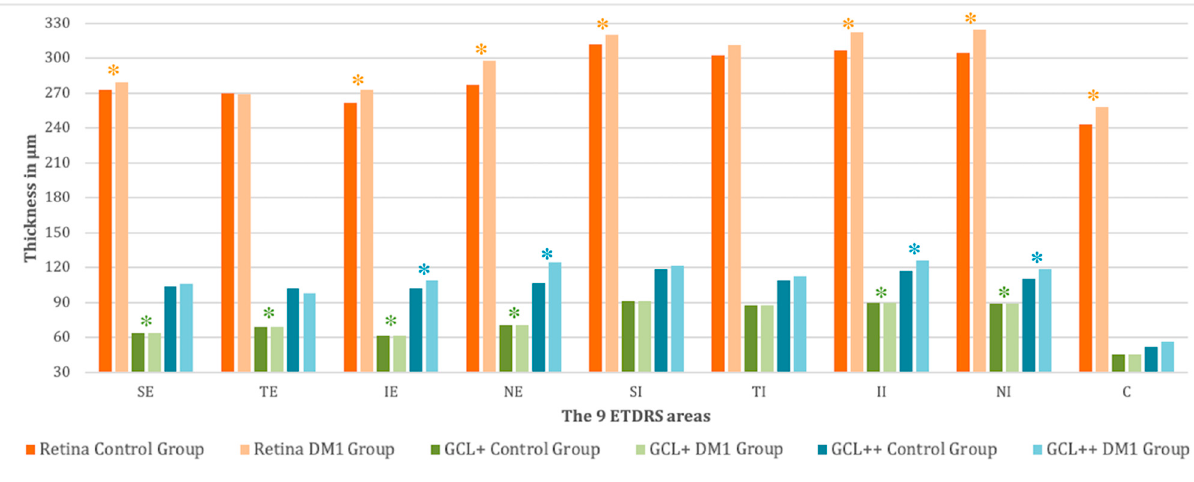
Figure 3. Mean thickness of the total retina (from the ILM line to the BM line), GCL+ (from the RNFL line to the IPL line) and GCL++ (from the ILM line to the IPL line) in the 9 ETDRS areas obtained by the DRI-Triton OCT for the control and the DM1 groups. Statistically significant differences between groups ( p < 0.05) are marked with *. The measures are divided into 9 ETDRS areas. SE, superior external; TE, temporal external; IE, inferior externa; NE, nasal external; SI, superior internal; TI, temporal internal; II, inferior internal; NI, nasal internal; and C, central. Thickness values are expressed as µ m.